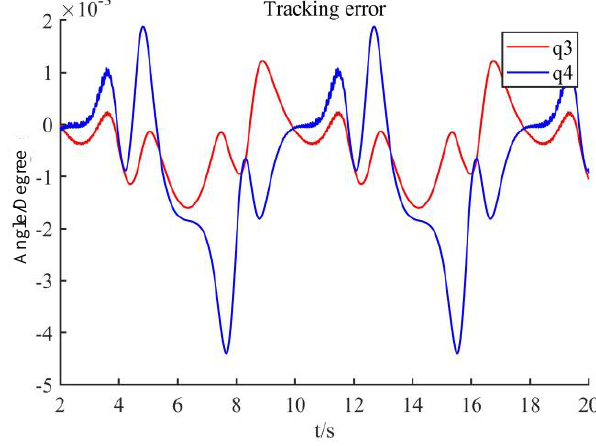
Figure 5. Joint’s tracking performance.